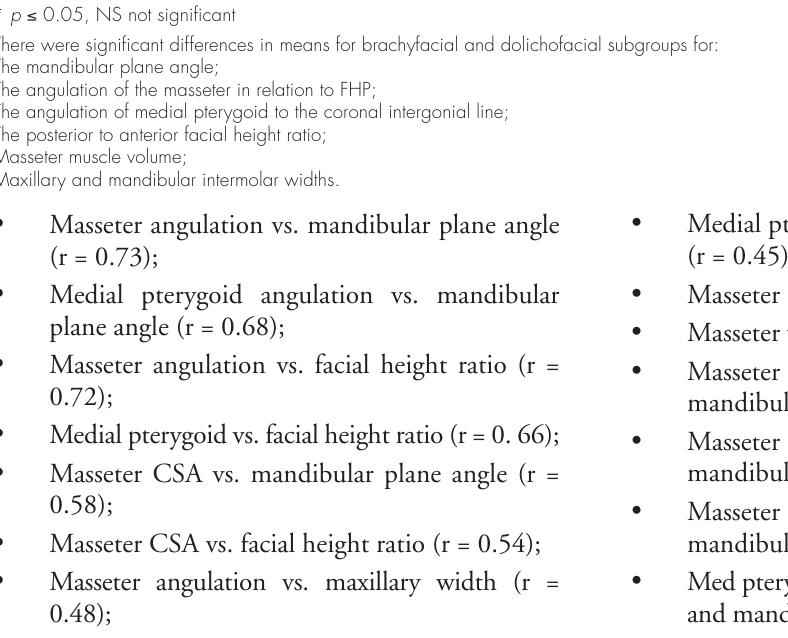
* p ≤ 0.05, NS not significant There were significant differences in means for brachyfacial and dolichofacial subgroups for: The mandibular plane angle; The angulation of the masseter in relation to FHP; The angulation of medial pterygoid to the coronal intergonial line; The posterior to anterior facial height ratio; Masseter muscle volume; Maxillary and mandibular intermolar